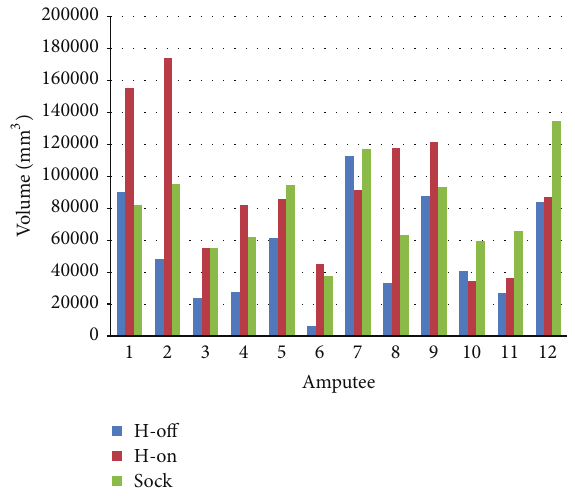
Figure 7: Stock volume, Hands-off, and Hands-on shape difference.